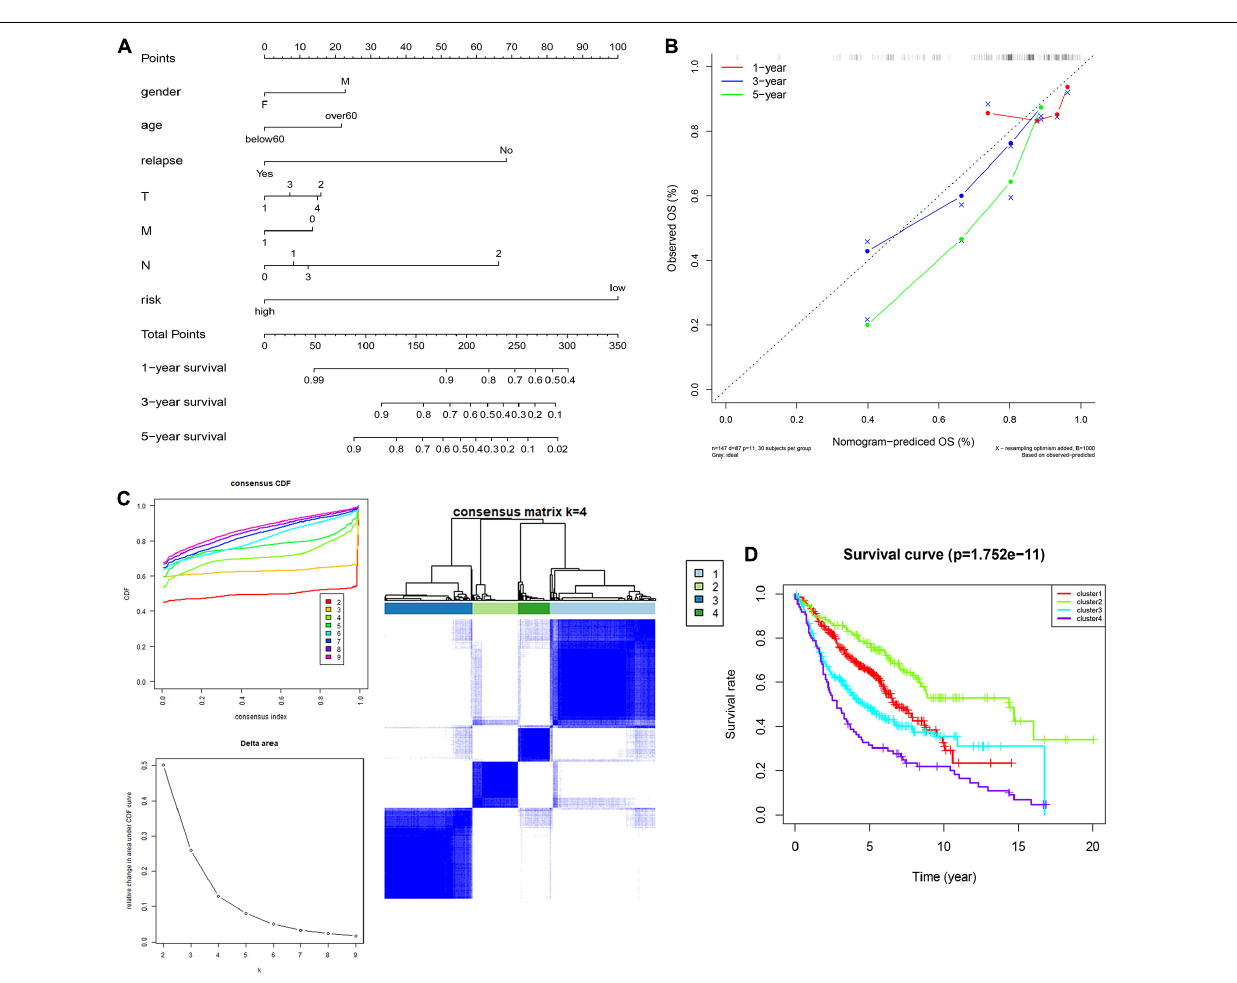
Frontiers in Cell and Developmental Biology |